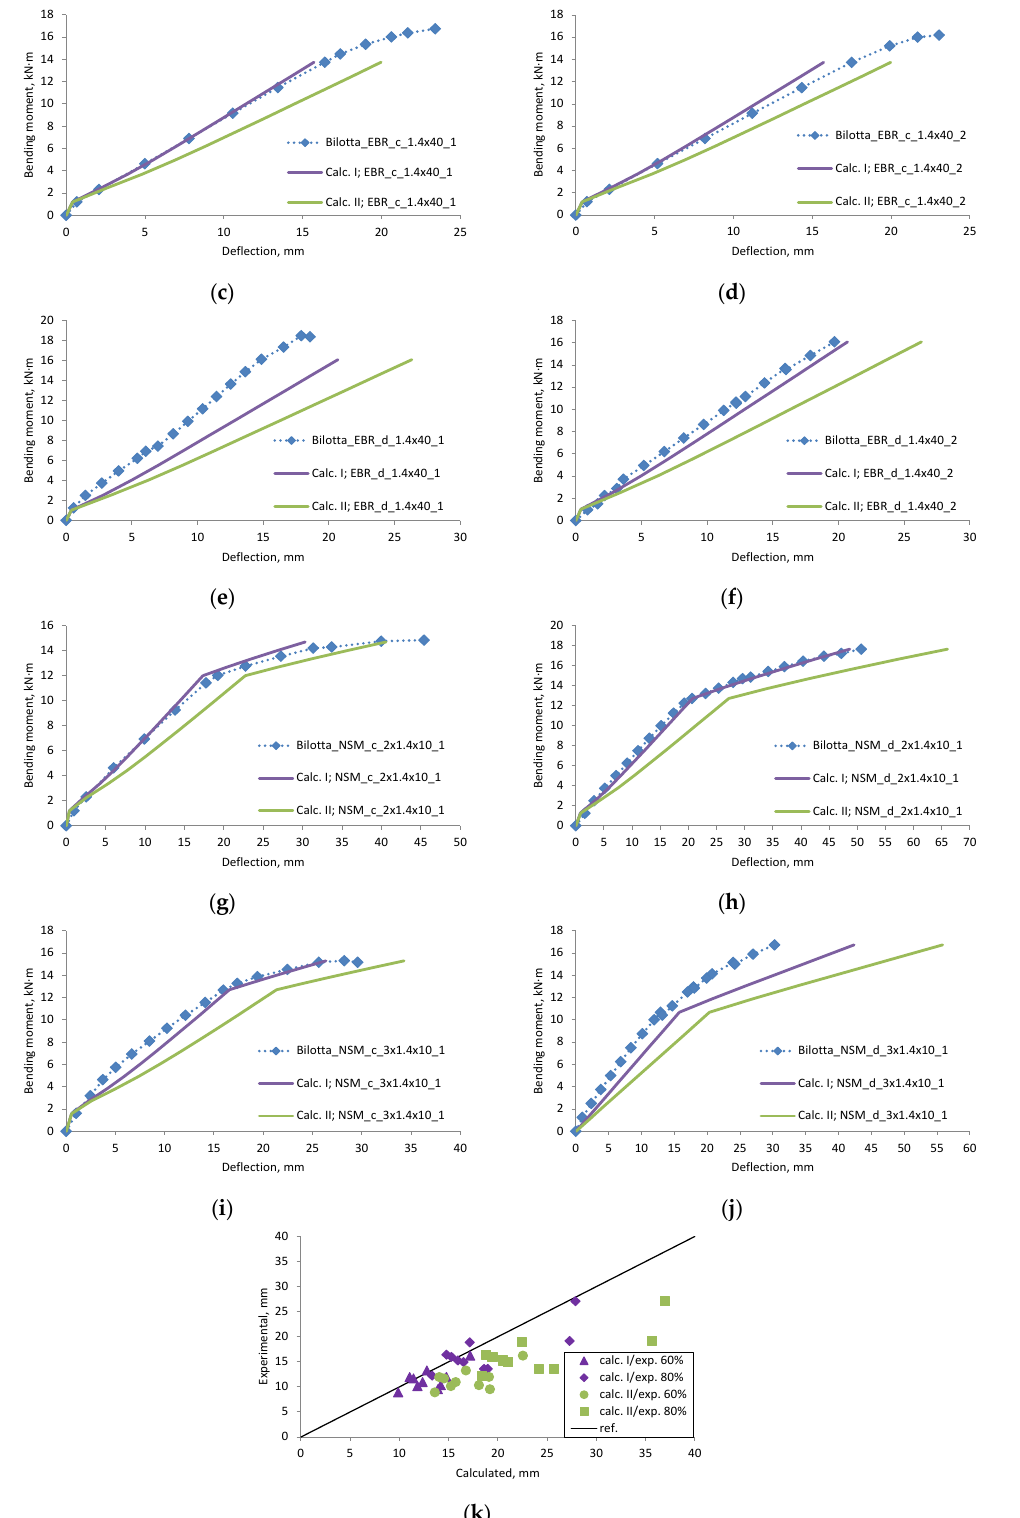
Figure A2. Bilotta et al., 2015 [25] research beams deflection compared with calculated, ( a ) beam Ref_c_no_1; ( b ) beam Ref_d_no_1; ( c ) beam EBR_c_1.4 × 40_1; ( d ) beam EBR_c_1.4 × 40_2; ( e ) beam EBR_d_1.4 × 40_1; ( f ) beam EBR_d_1.4 × 40_2; ( g ) beam NSM_c_2 × 1.4 × 10_1; ( h ) beam NSM_d_2 × 1.4 × 10_1; ( i ) beam NSM_c_3 × 1.4 × 10_1; ( j ) beam NSM_d_3 × 1.4 × 10_1; ( k ) scatter of the results at 60% and 80% of the ultimate